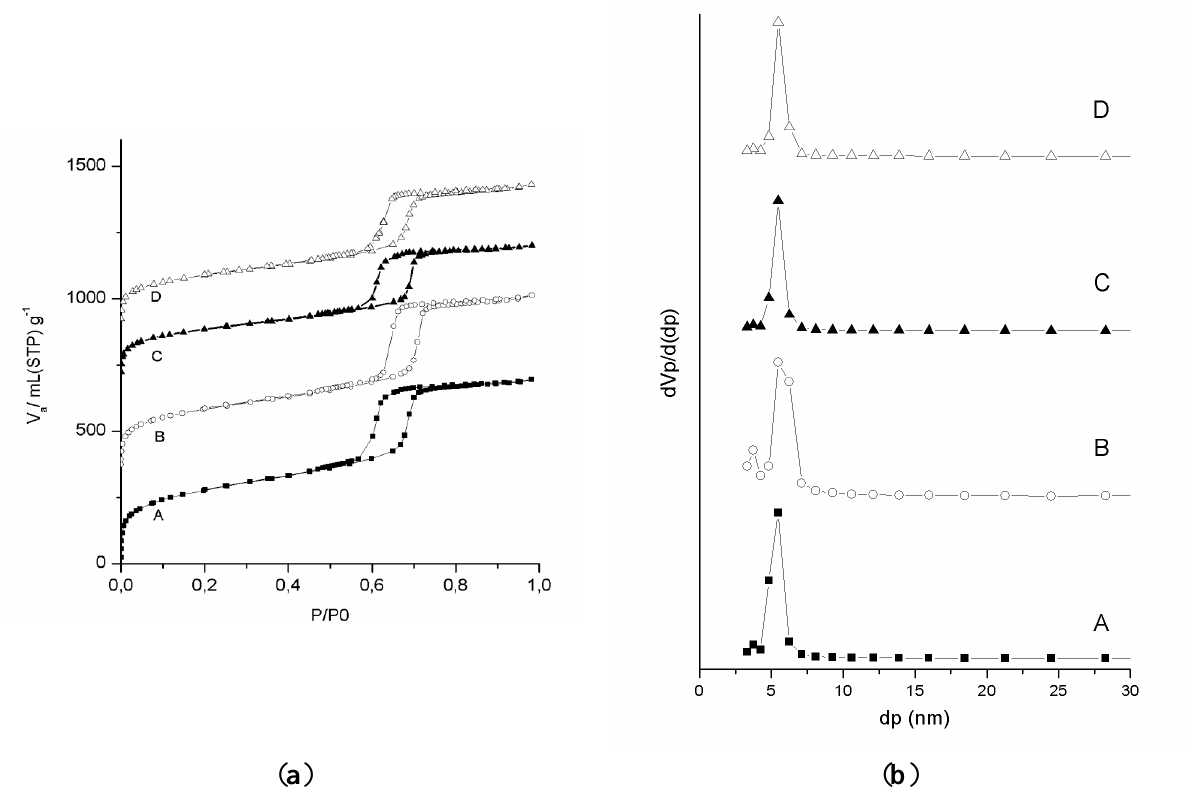
Figure 2. The nitrogen adsorption and desorption isotherms ( a ) and pore size distributions ( b ) of (A) EP; (B) BEP; (C) EP–(CH BEP, EP–(CH ) –SH and EP–(CH 2 3 900 mL (STP) g −1 (Standard Temperature and Pressure),